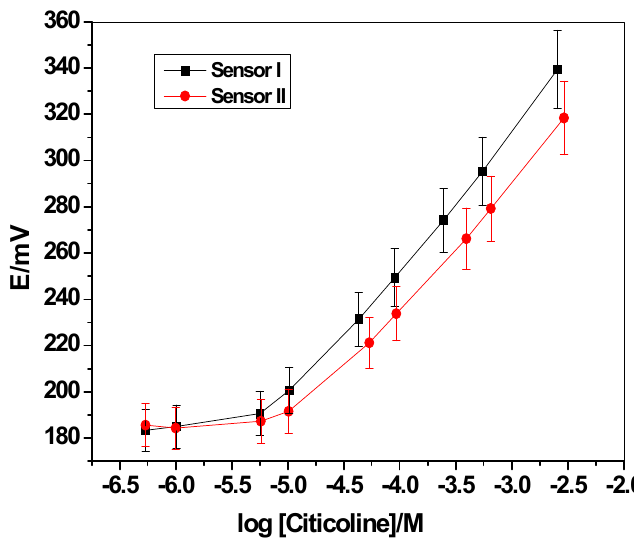
Figure 2. Calibration plot of the suggested citicoline membrane-based sensors.